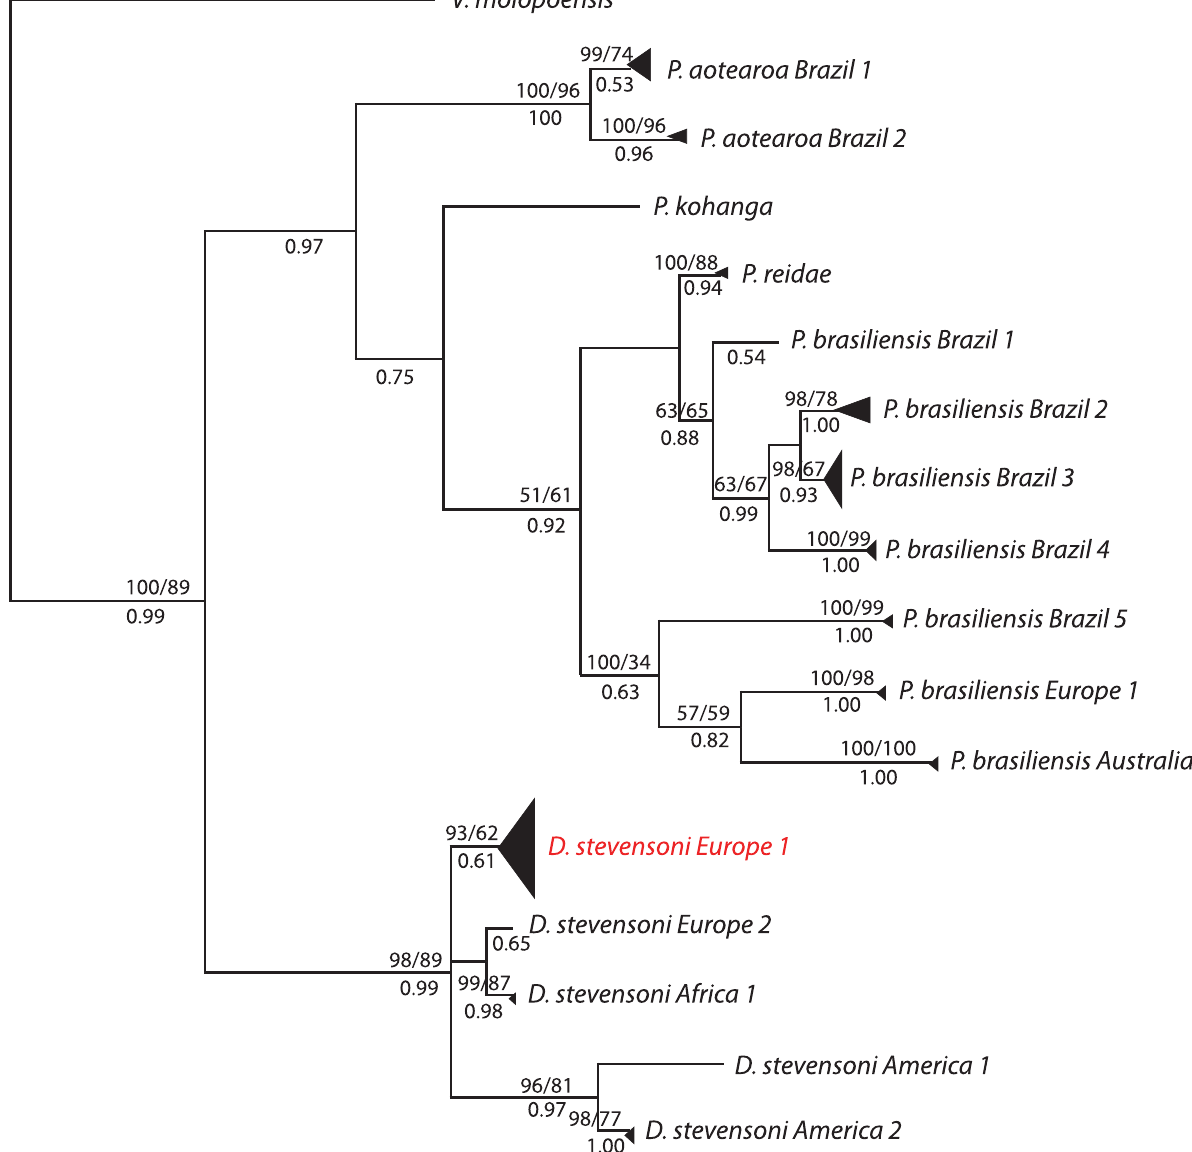
Figure 1. COI phylogeny of the three darwinulid genera. This phylogeny was obtained by Bayesian Inference. Height of triangles reflects the number of sequences. Triangles or single branches represent EG species, which are indicated by their geographic origin and Arabic numbers. Species names in red are split into two species by the GMYC method (but not by the K/ h method). Species names in black are recognized by both methods. Numbers above branches are bootstrap values of 1000 replicates for NJ and ML trees ( . 50%), numbers below branches are posterior probabilities of Bayesian Inference. doi:10.1371/journal.pone.0039844.g001 Brazilian clades, one European and one Australian clade of P. brasiliensis , respectively.